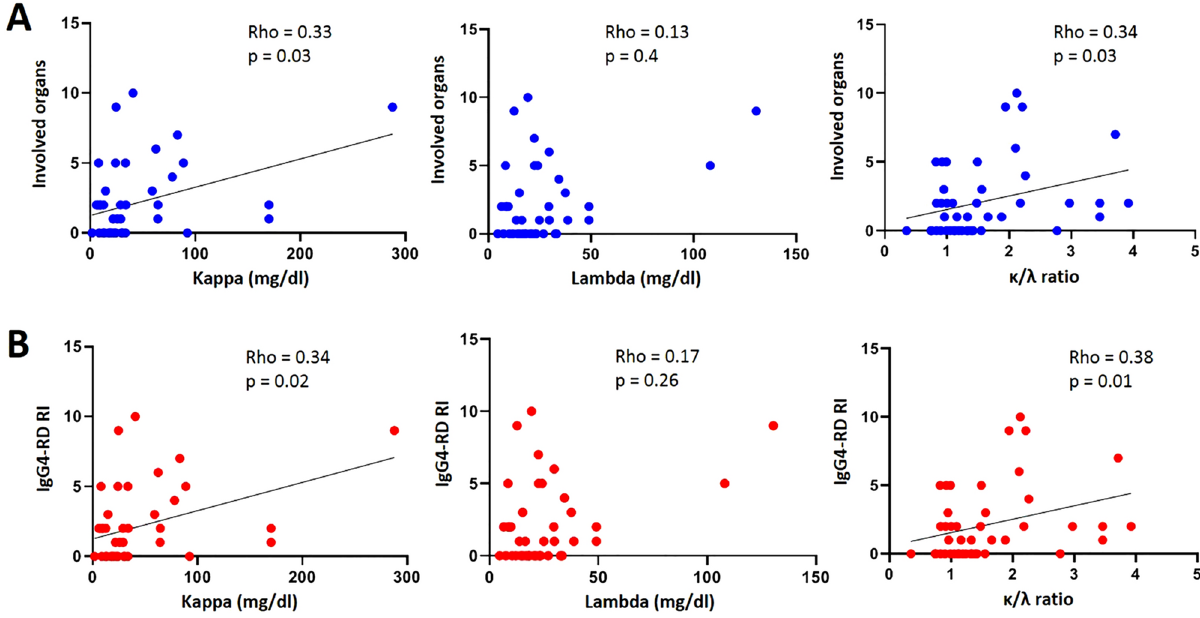
Figure 4. Relationship between κ and λ serum free light chains and the κ/λ ratio and clinical parameters in the IgG4-related disease patients (n = 45). ( A ) Correlation between the number of involved organs and the levels of κ and λ serum free light chains and the κ/λ ratio. ( B ) Correlation between the IgG4-RD RI and the levels of κ and λ serum free light chains and the κ/λ ratio. All correlations were determined using Spearman’s test. IgG4-RD RI IgG4-related disease responder